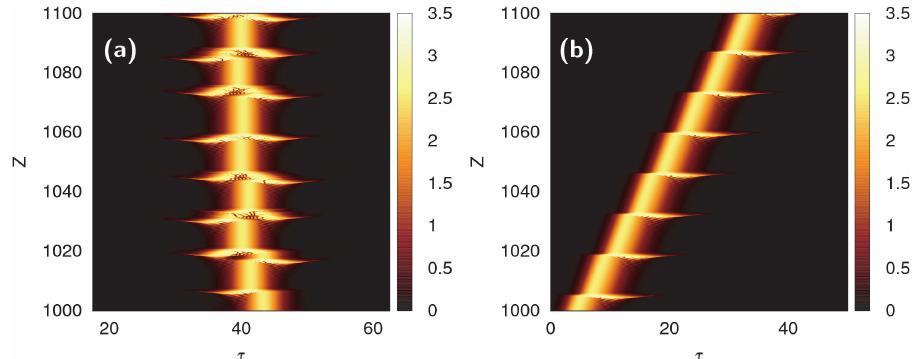
Figure 5. τ − z plot of | A | following the dimensionless complex CQGLE (8) for (cid:101) = 1.02, ( a ) without including higher-order effects, showing chaotic explosions, and ( b ) including higher-order effects, showing periodic